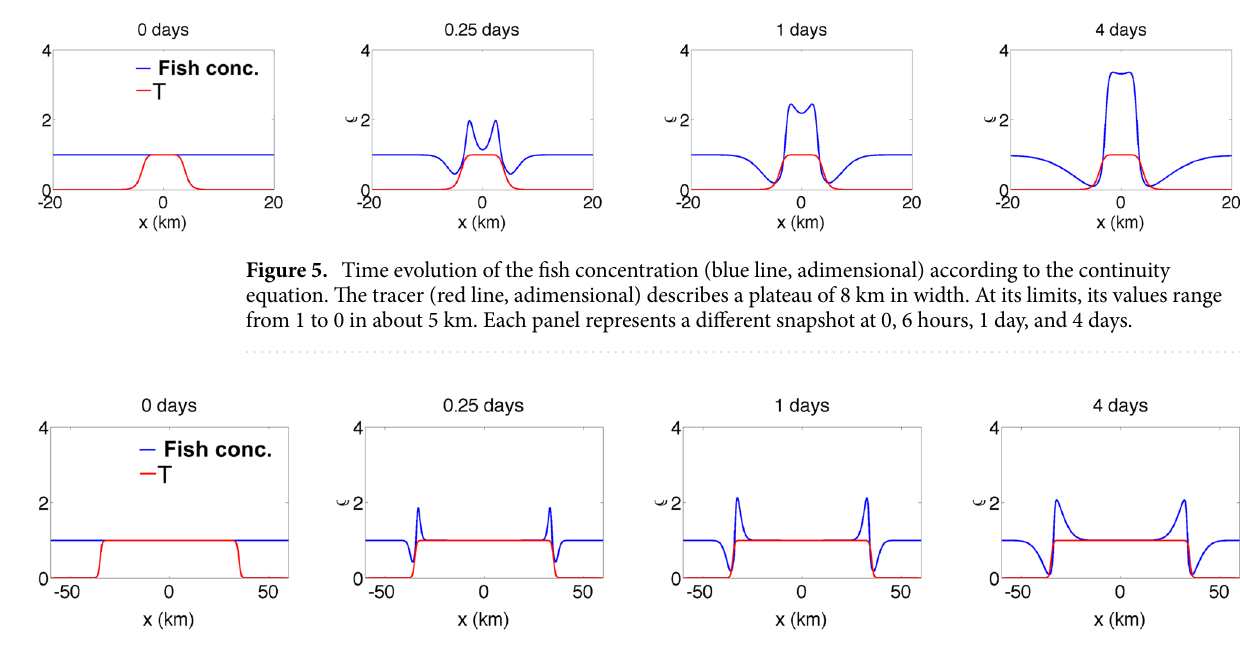
Figure 6. Time evolution of the fish concentration as reported in Fig. 5. This time, the plateau width has been set to 70